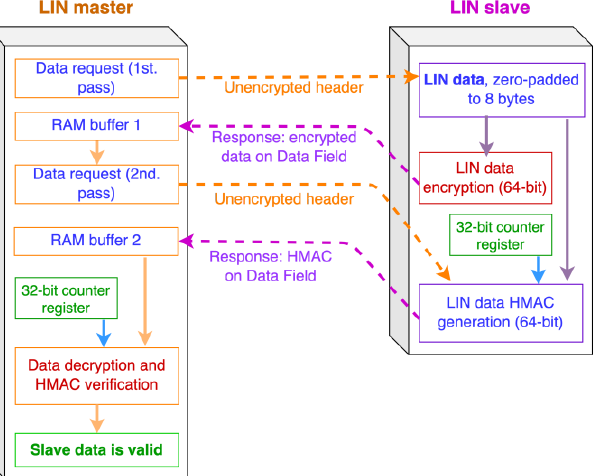
Figure 4. Proposed LIN communication sequence using 64-bit encryption and HMAC on alternate frames.